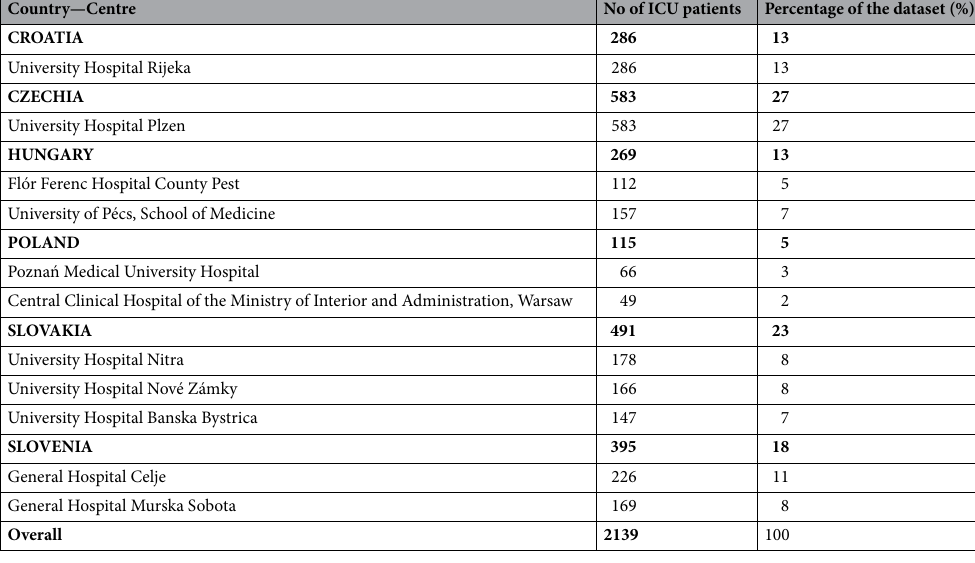
Table 1. Participating